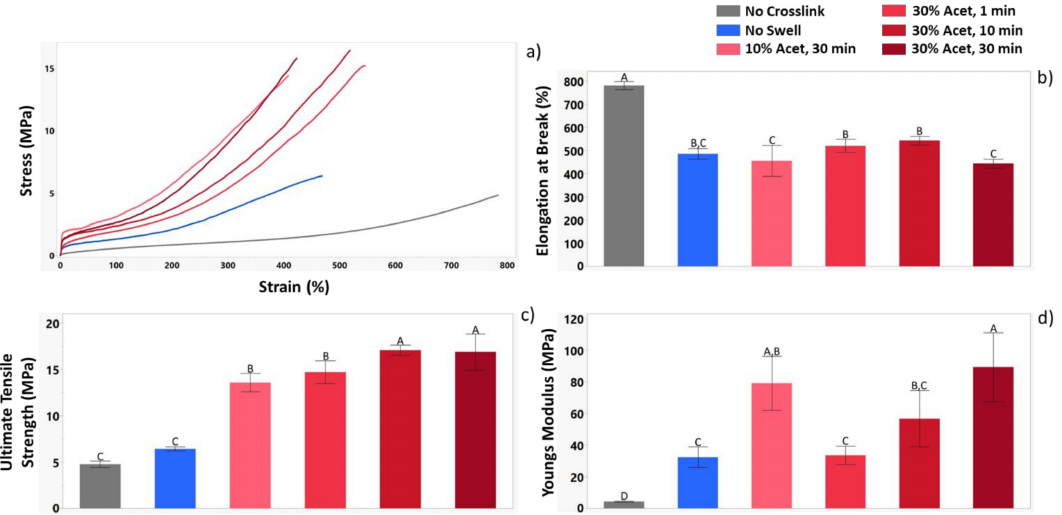
Figure 4. Tensile data for each of the sample groups demonstrating the influence of crosslinking parameters on mechanical properties. Results presented include ( a ) Representative stress-strain curves ( b ) elongation at break ( c ) ultimate tensile strength (UTS) and ( d ) Young’s modulus. n = 3 for all conditions tested. For the letters used on the bar graphs in (A–D), shared letters between the samples indicate no statistical differences, while a lack of shared letters indicates a statistical